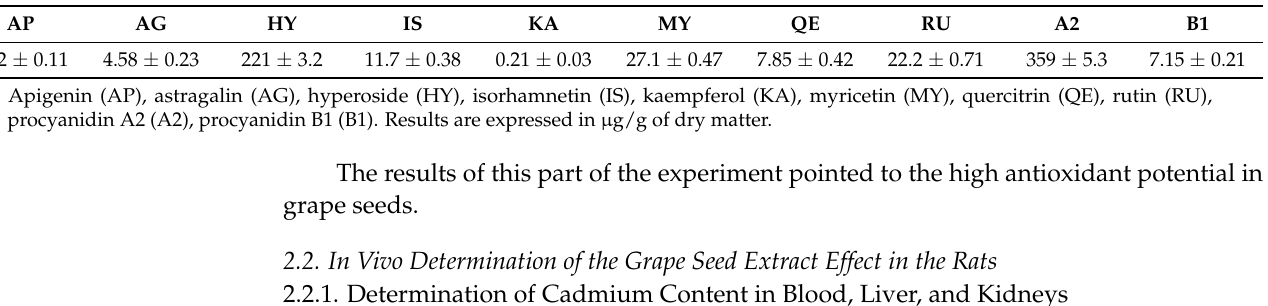
Table 2. Content of selected antioxidant components in grape seed